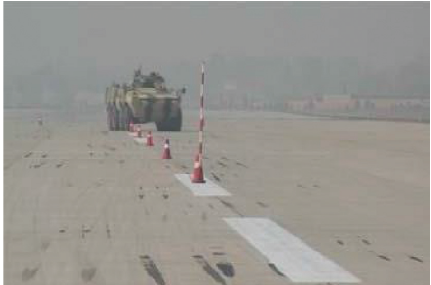
Figure 13: 8WIDEV experiment at the test